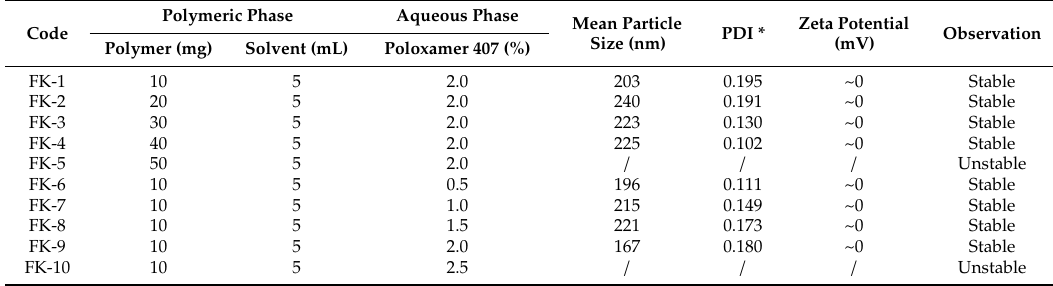
Table 1. Composition of di ff erent formulations used in the